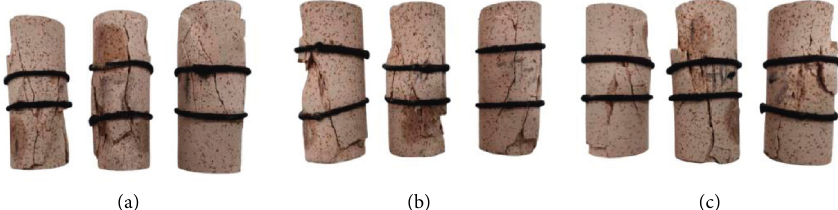
Figure 12: Uniaxial compression of yellow sandstone after freeze-thaw cycles. (a) Group D loading results. (b) Group E loading results. (c) Group F loading results.